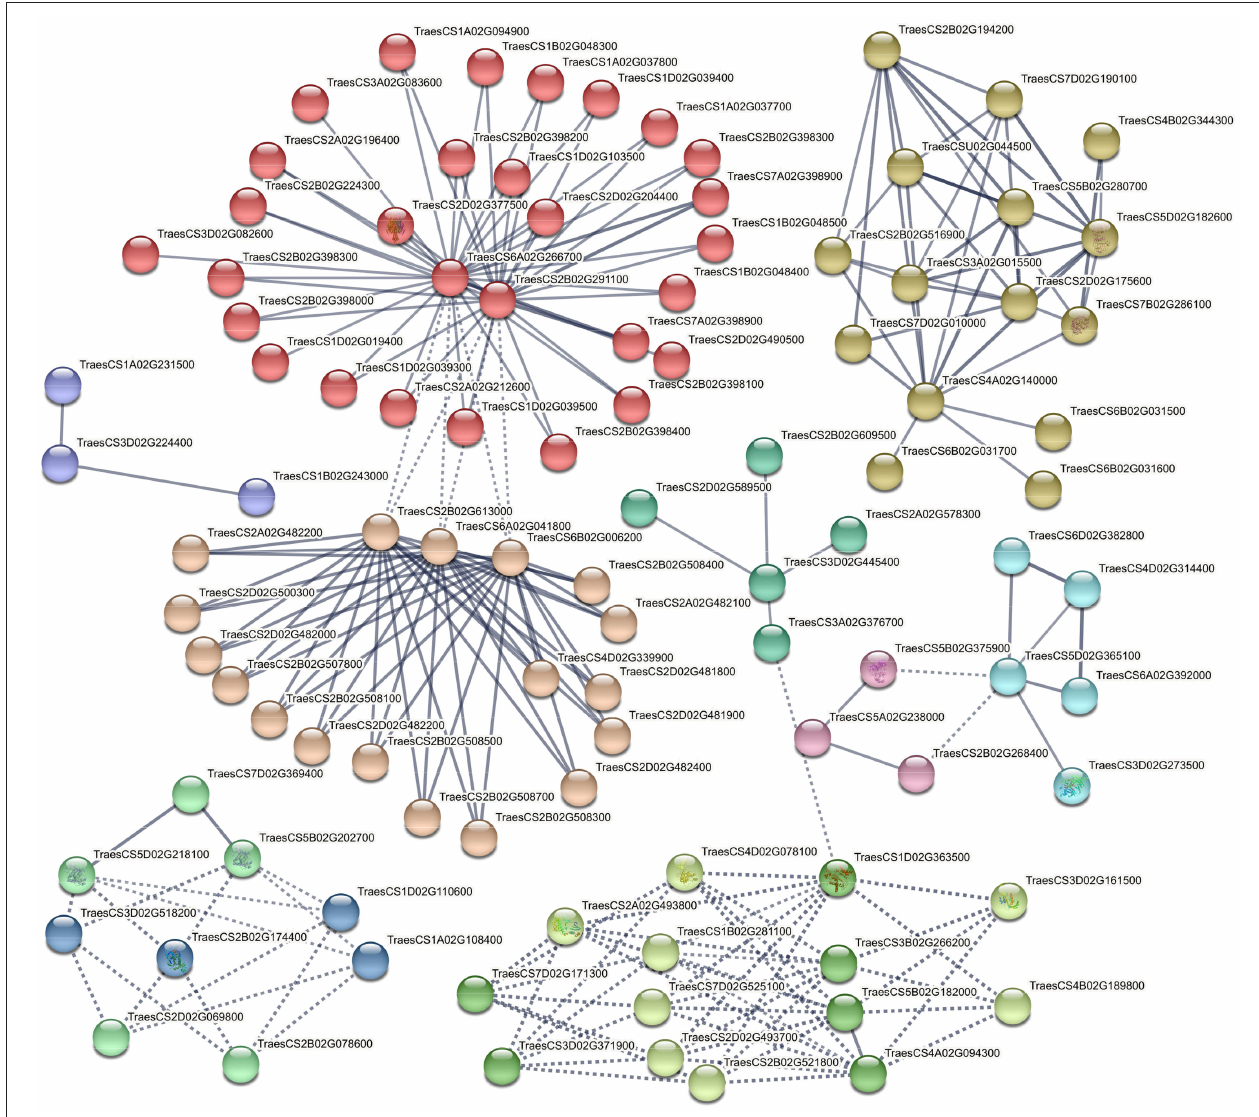
FIGURE 9 | Interaction networks of related DEGs in significant KEGG pathways and putative TFs identified by comparing water deficit vs. control. e.g., TraesCS2D02G377500 (Phenylalanine ammonia-lyase), TraesCS6A02G041800 (Anthocyanidin synthase/TaANS-A2), TraesCS6A02G001500